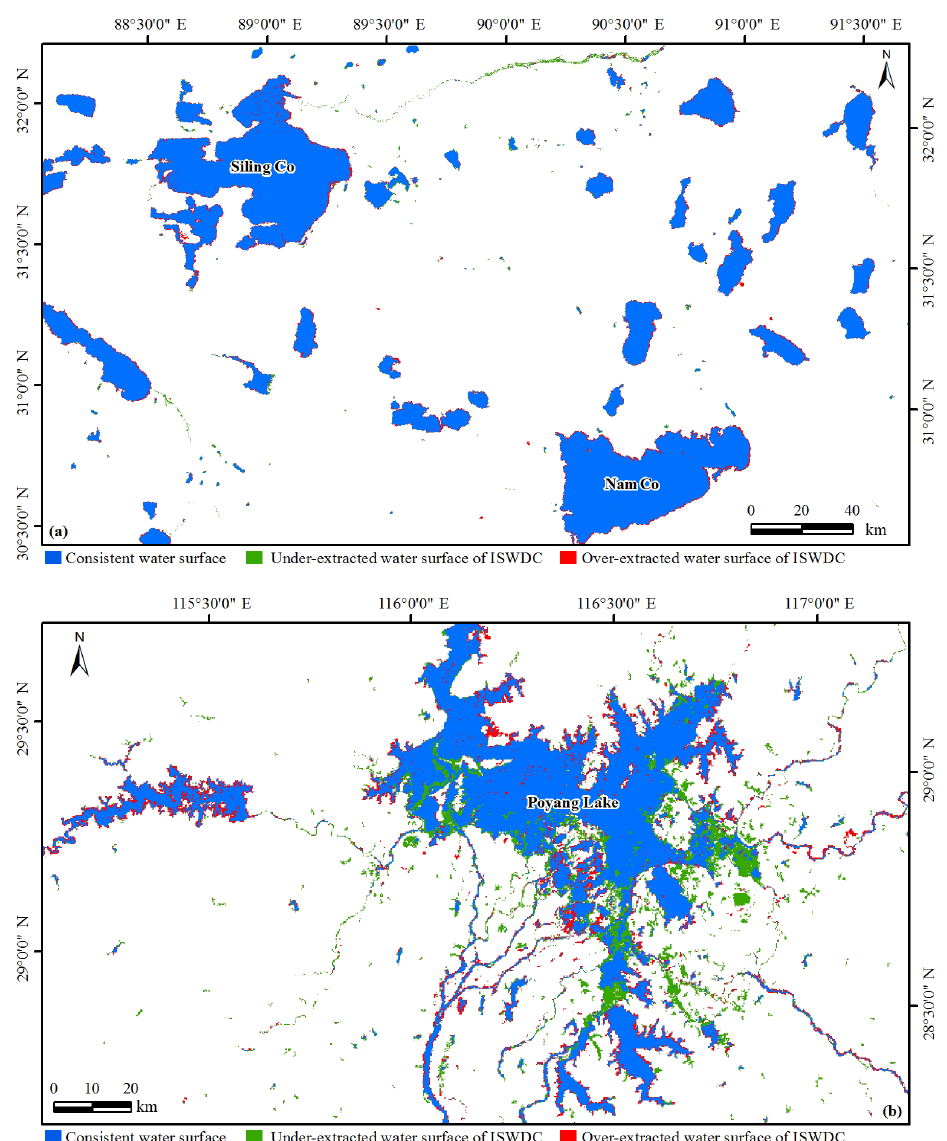
Figure 5. Comparison of permanent water bodies derived from ISWDC and GSW over the sites of the central Tibetan Plateau (a) and Poyang Lake region (b)